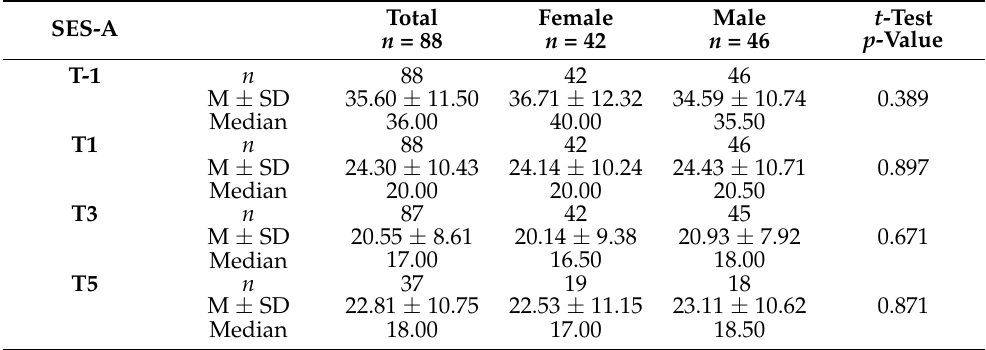
Table 2. Affective pain perception (SES-A) from hospital admission (T-1) to day 5 after operation (T5). p -values of t-test comparisons between men and women.